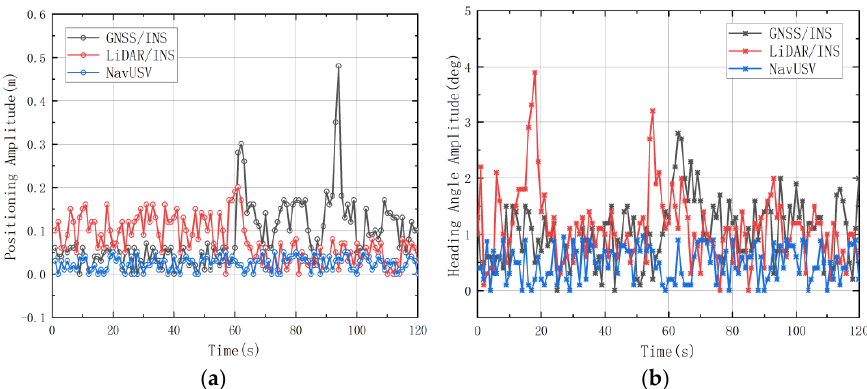
Figure 6. Data amplitude for dynamic switching of sensors: ( a ) Positioning data amplitude before and after switching; ( b ) Heading angle amplitude before and after switching.